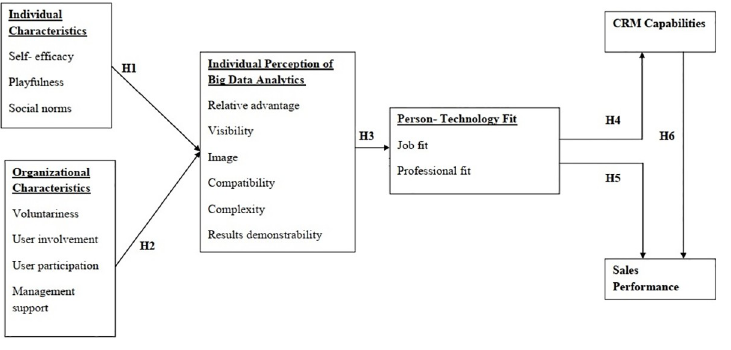
Fig 1. Proposed research